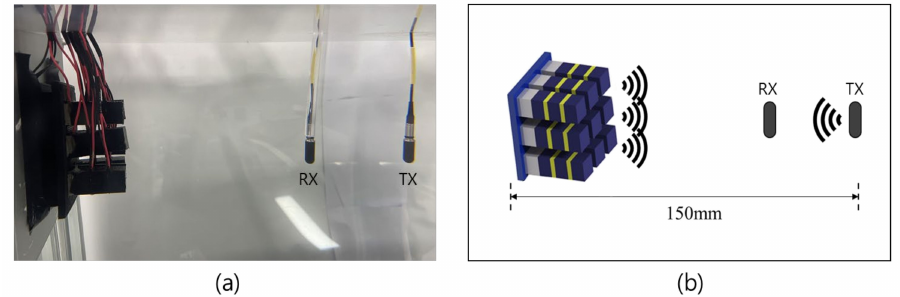
Figure 10. Experimental setting: ( a ) actual setting, ( b ) schematic of the experimental setting.